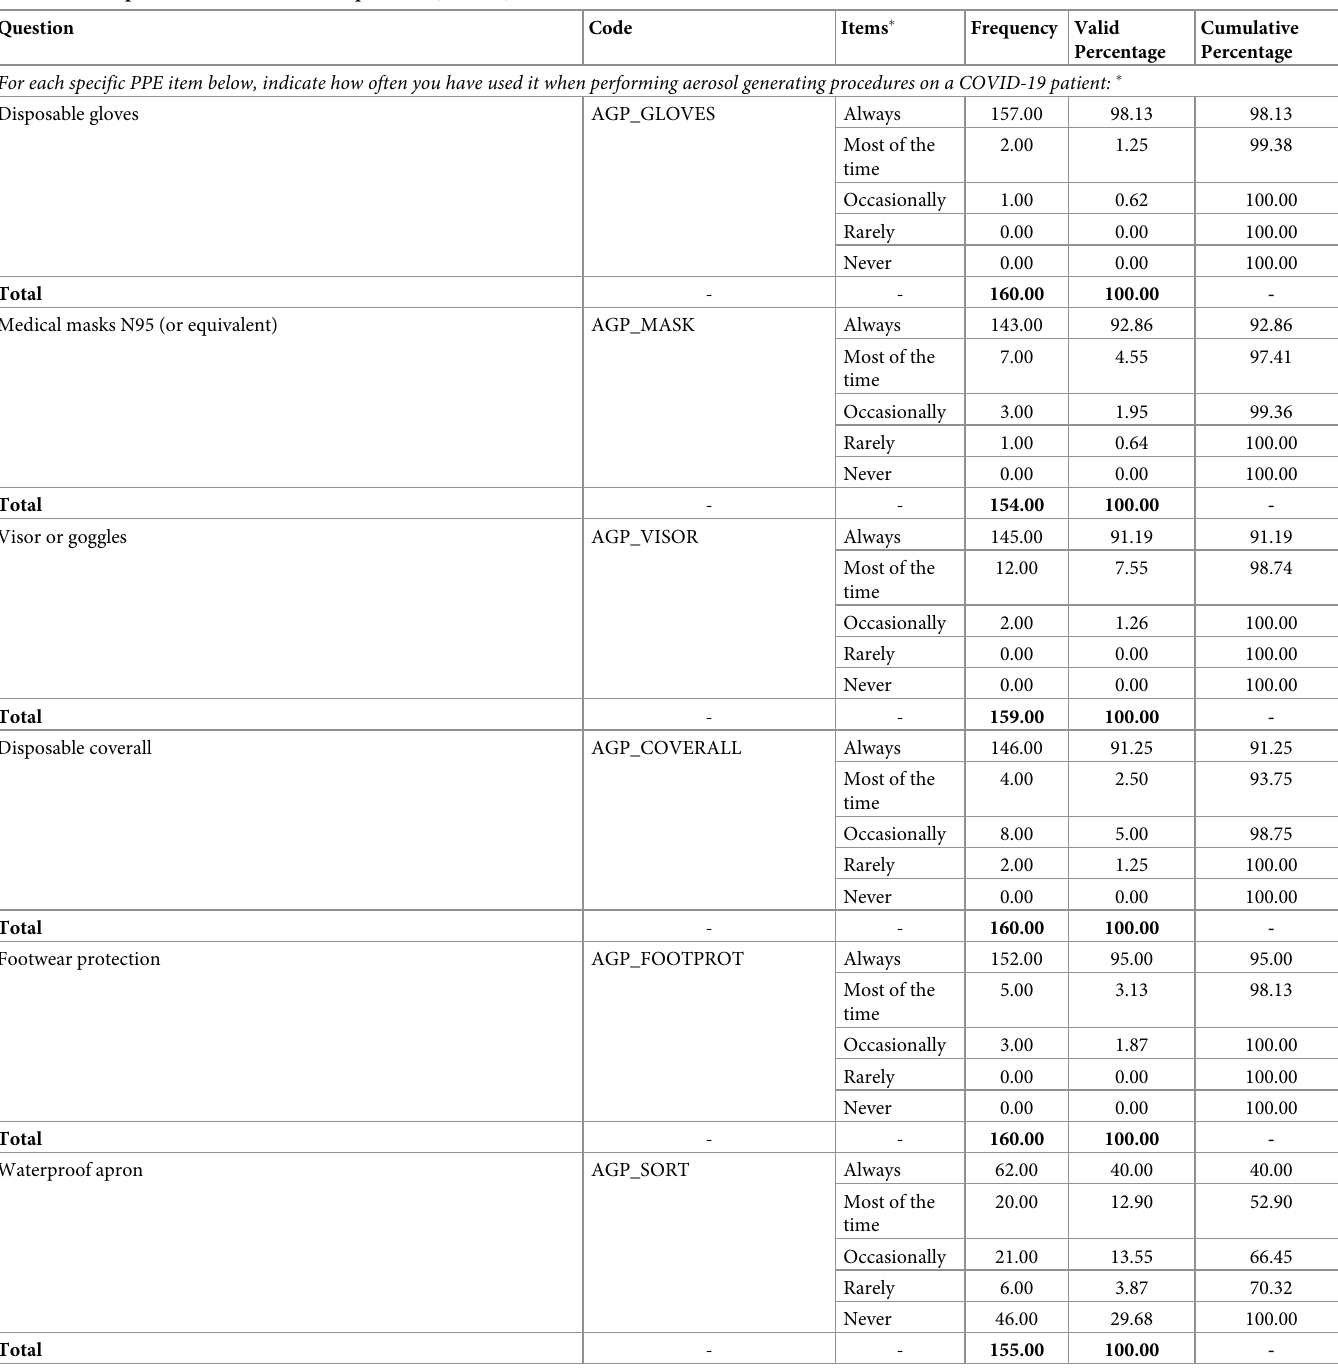
Table 2. Descriptive statistics for research questions (N =